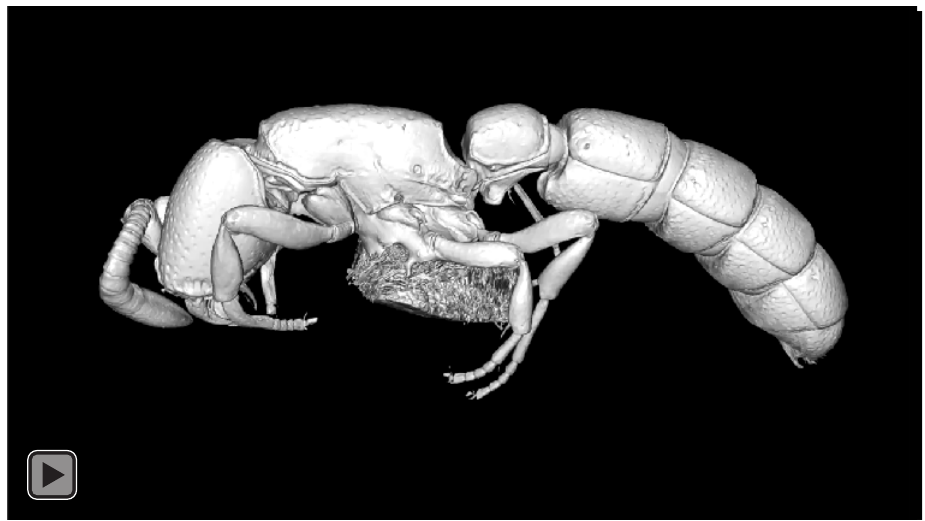
Video 1. 3D rotation video of Zasphinctus obamai sp. n. holotype worker (CASENT0764125) based on shaded volumetric surface rendering of full